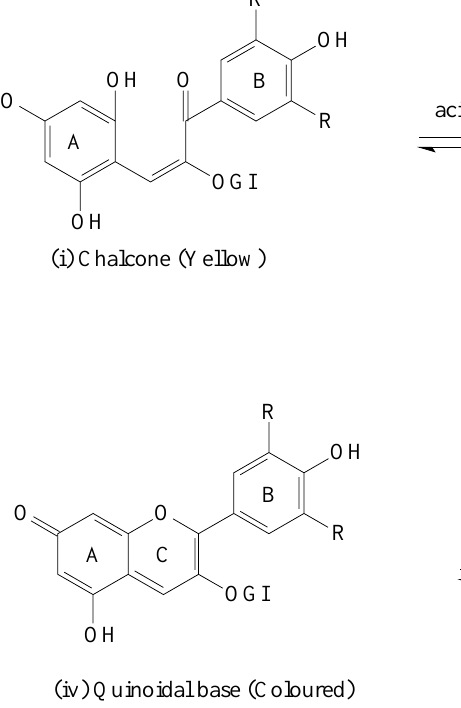
(Coloured)(iv) Quinoidal base